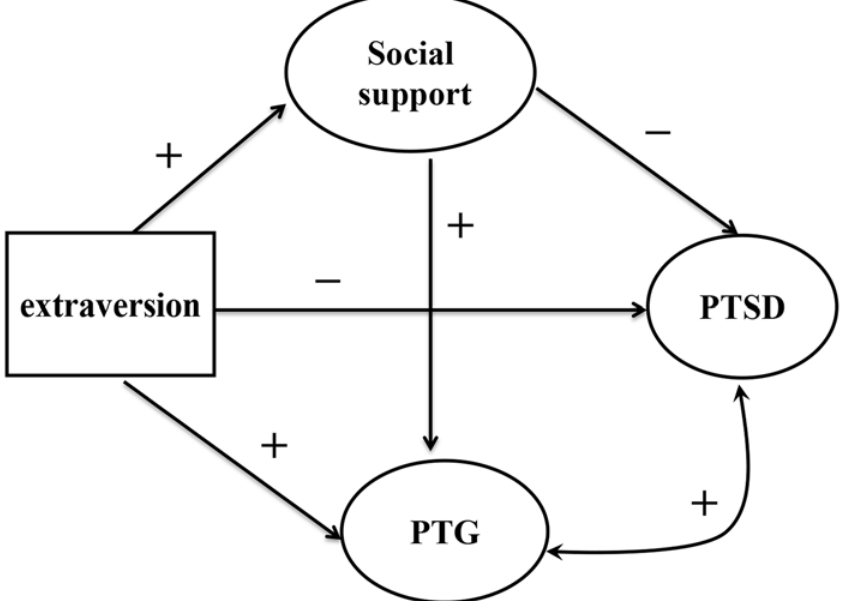
Fig 1. The hypothesized model of posttraumatic growth. This figure describes the hypothesized paths of extraversion, social support, posttraumatic stress disorder, and posttraumatic growth. PTSD = posttraumatic stress disorder; PTG = posttraumatic growth; arrows imply the directionality in the model, “ + ” indicates a positive prediction, “—” indicates a negative prediction.